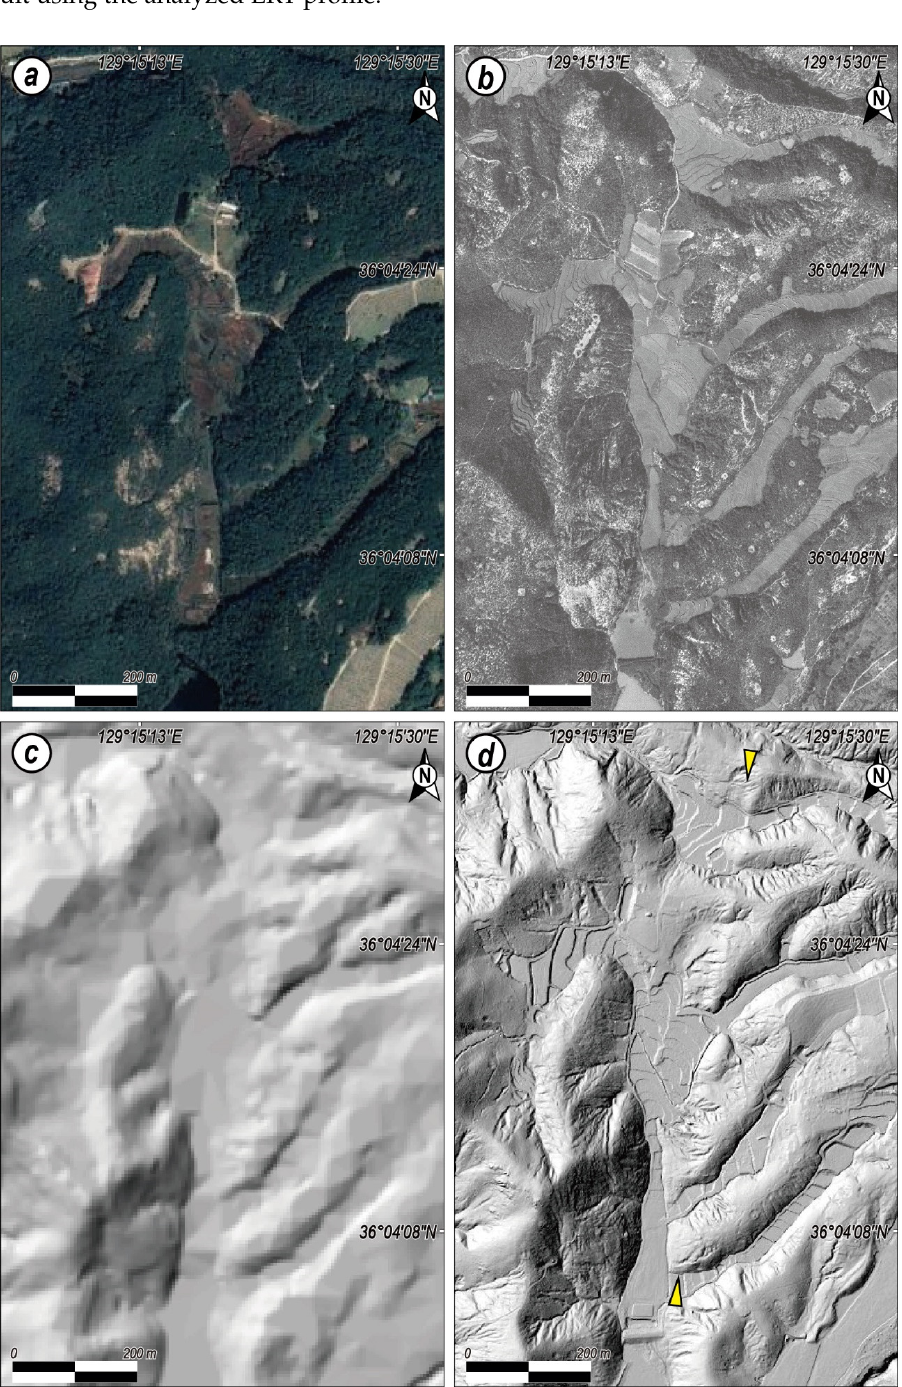
Figure 3. Resolution comparison of various remote sensing technologies for the same area. ( a ) Google Earth Pro satellite image. ( b ) Aerial photography (1970s). ( c ) Hillshade using 1:5000 digital topographic maps (5 m resolution). ( d ) High-resolution LiDAR image hillshade. The yellow arrow indicates a fault scarp which was not observed in other images (0.5 m resolution).